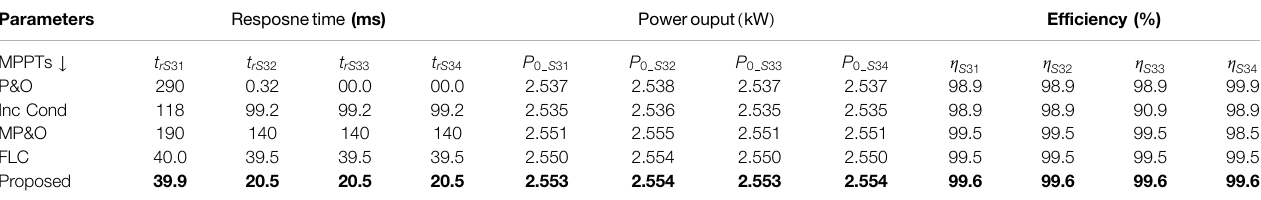
TABLE 5 | Performance comparison analysis of simulation results validated under scenario-III. Parameters